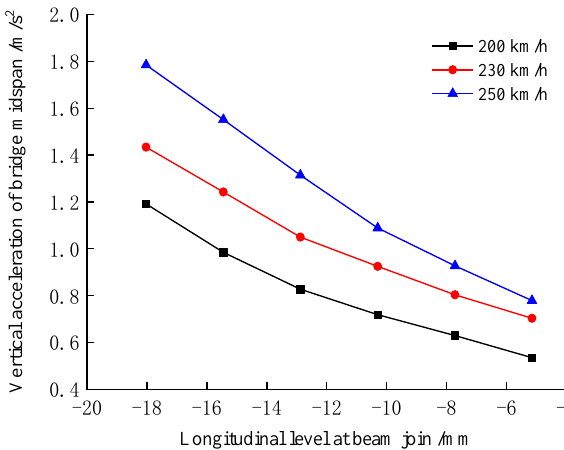
Figure 24. Vertical acceleration of bridge midspan.